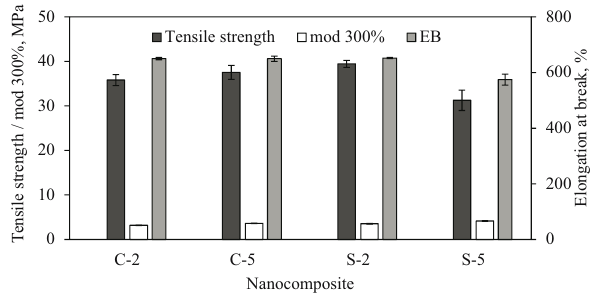
Figure 9: Tensile properties of cured nanocomposites.